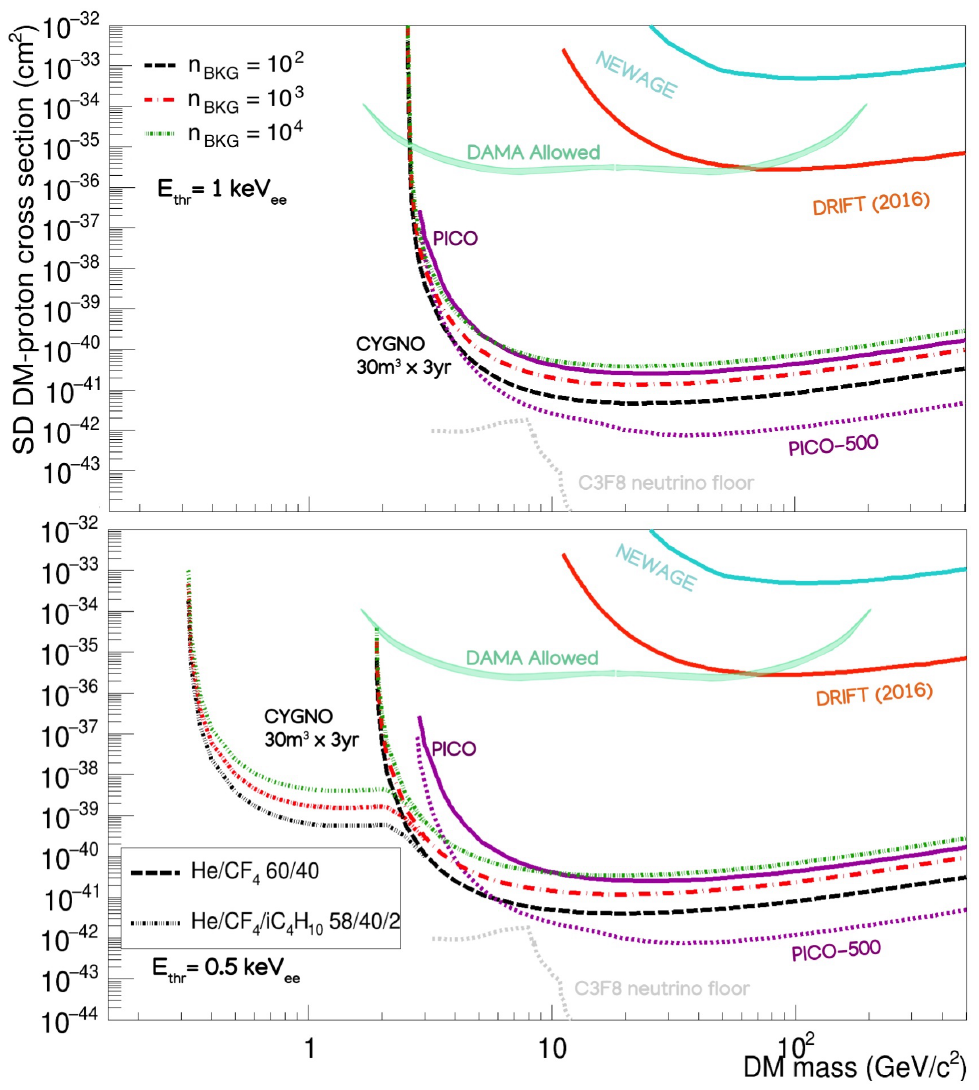
Figure 15. Spin-dependent sensitivity for WIMP–proton cross sections for 30 m 3 CYGNO detector for 3 years of exposure with different background level assumptions and an operative threshold of 1 keV ( top plot) and 0.5 keV ( bottom plot). The dashed curves correspond to N bkg = 100 (black), 1000 (red) and 10,000 (dark green). The dotted curves show the sensitivity for a HeCF 4 :isobutane 58/40/2 mixture. Current bounds from PICO (purple) [88], DRIFT (orange) [61], and NEWAGE (cyan) [89] are also shown. The allowed region by DAMA is denoted by the light green band [90]. The light gray dotted line representing the neutrino floor for C 3 F 8 is also taken from PICO